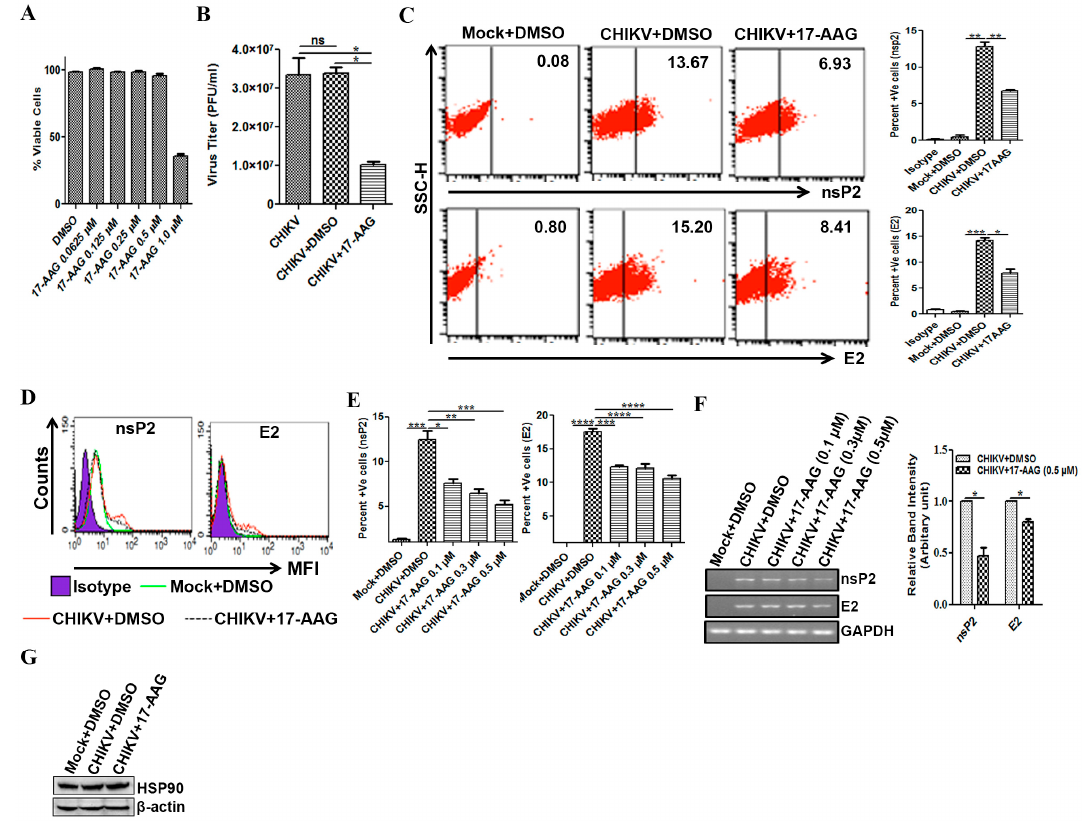
Figure 5. Modulation of CHIKV infection by 17 ‐ AAG in macrophages. Raw cells were infected with CHIKV at MOI 5. The cells were treated with either DMSO or 17 ‐ AAG as described earlier. ( A ) Percent viable cells treated with different concentrations of 17 ‐ AAG with respect to the solvent control (DMSO) as determined by MTT assay. ( B ) Line diagram showing CHIKV titer as PFU/mL in CHIKV, CHIKV + DMSO and CHIKV + 17 ‐ AAG (0.5 μ M) at 12 hpi. ( C ) Representative dot plot analysis depicting percent positive cells for nsP2 and E2 at 8 hpi. Bar diagram showing percent positive cells for nsP2 (upper panel) and E2 (lower panel) in different samples at 8 hpi. ( D ) MFI representing expression of nsP2 and E2 in isotype (purple filled), mock + DMSO (green solid line), CHIKV + DMSO (red solid line) and CHIKV + 17AAG (black dashed line) at 8 hpi. ( E ) Graphical representation showing percent positive cells for nsP2 (left) and E2 (right) at 0.1 μ M, 0.3 μ M and 0.5 μ M 17 ‐ AAG treatments at 8 hpi. ( F ) Agarose gel picture showing RT ‐ PCR of nsP2 and E2 (left) and bar diagram (right) showing reduction in the CHIKV RNA synthesis in Raw cells after 0.5 μ M 17 ‐ AAG treatment at 8 hpi. ( G ) Representative Western blot showing HSP90 level for mock + DMSO, CHIKV + DMSO and CHIKV + 17 ‐ AAG at 8 hpi. Data represent mean ± SEM of at least three independent experiments. p < 0.05 was considered as statistically significant difference between the groups. (ns, non ‐ significant; * p < 0.05; ** p ≤ 0.01; *** p ≤ 0.001).